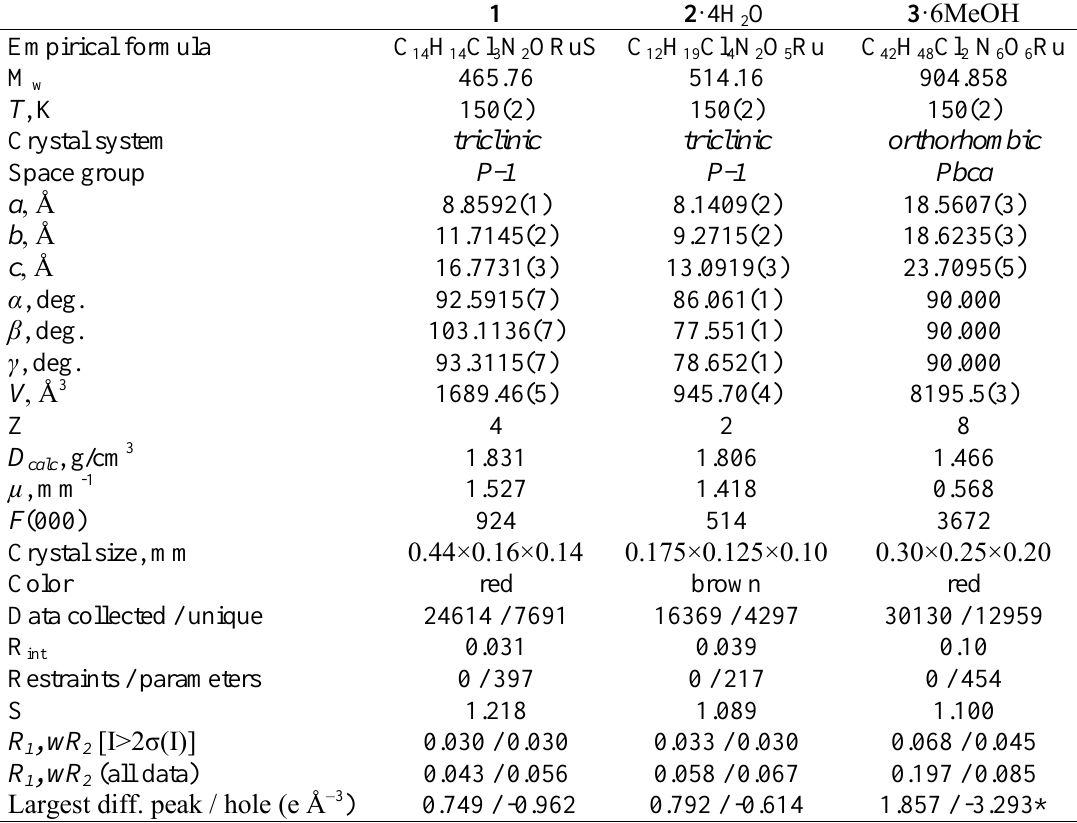
O and 3 ·6MeOH . 2